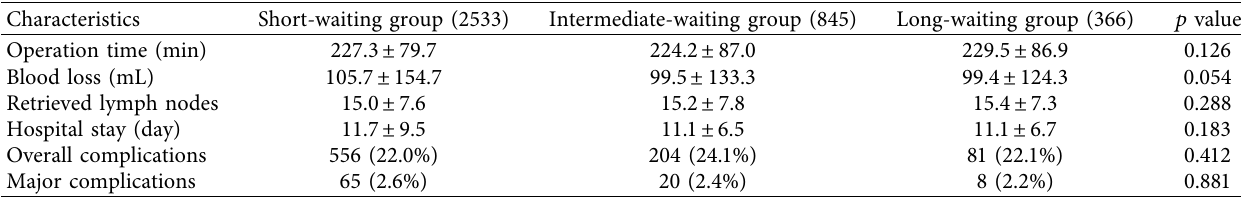
Table 2: Short-term outcomes of the different waiting